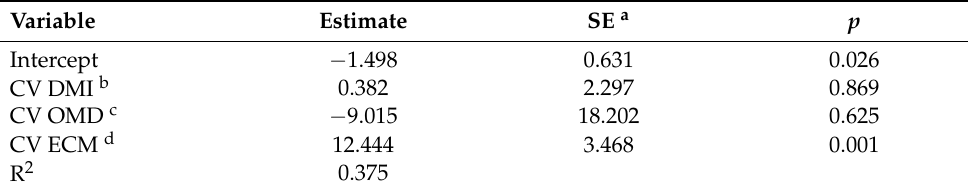
Table 4. The effect of variation in sub-variables on variation in energy balance (EB) ( n = 28).